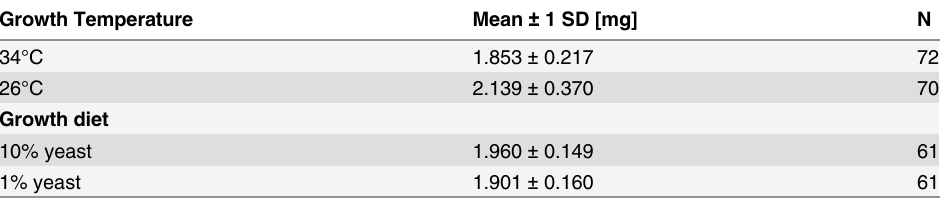
Table 1. Female mass under different thermal and diet growth